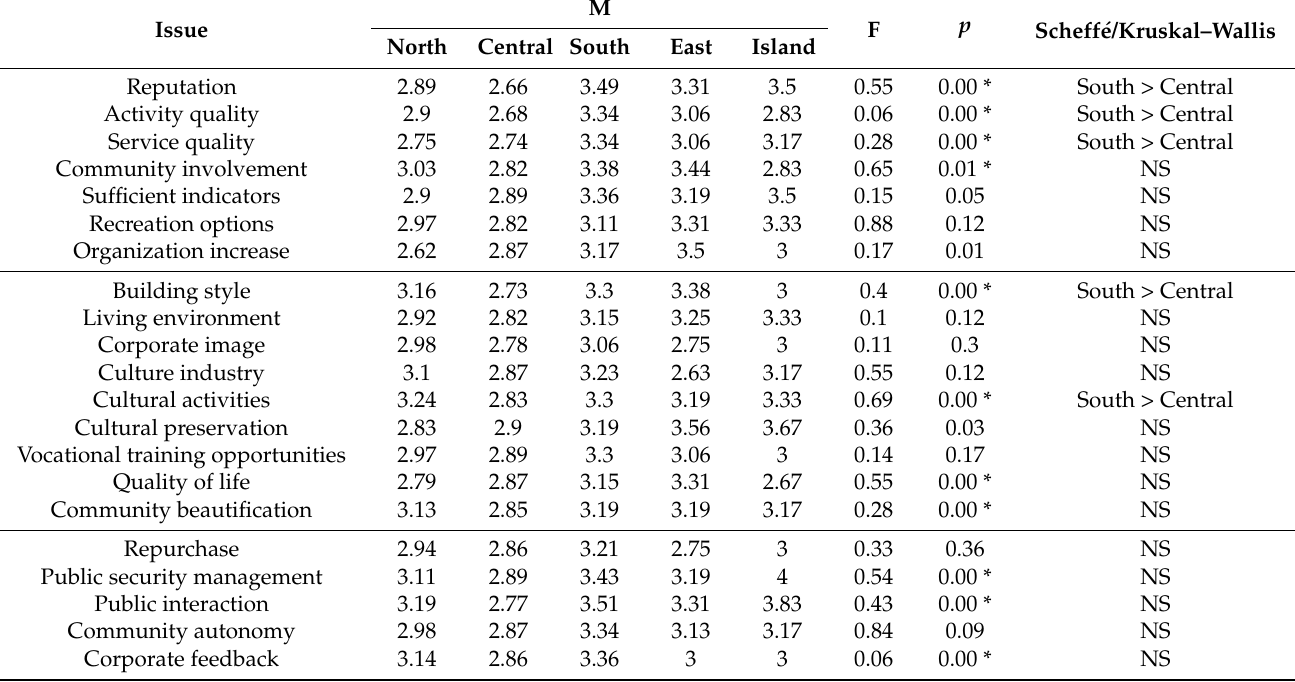
Table 5. Analysis of cognition of social development of tourists from different